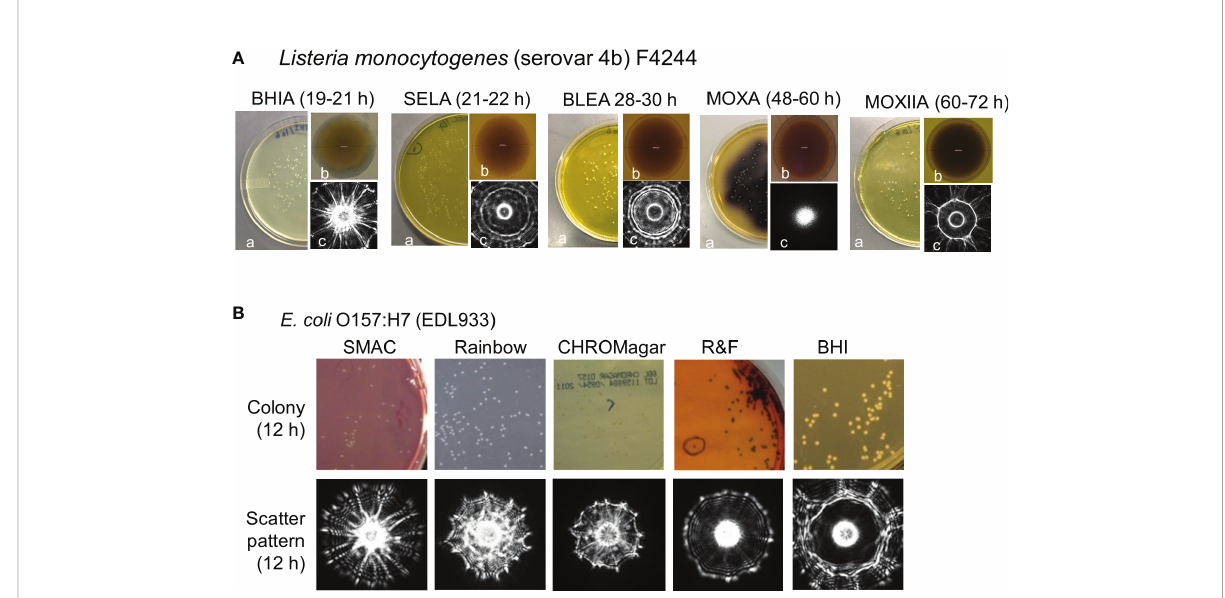
FIGURE 2 Variation in colony appearance and scatter signatures of ( Listeria monocytogenes (A) and E . coli O157:H7 (B) grown on various growth media: BHIA, brain heart infusion agar; SELA, Salmonella Escherichia Listeria agar; BLEA, Buffered Listeria enrichment agar; MOXA, modi fi ed Oxford agar; MOXIIA, modi fi ed Oxford agar media without ferric ammonium citrate. a, Petri dish with colonies; b, individual colony magni fi ed 100x; c, corresponding scatter signature (Abdelhaseib et al., 2019). (B) : SMAC, sorbitol MacConkey; Rainbow; CROMagar, R&F and BHI were used) (Tang et al.,